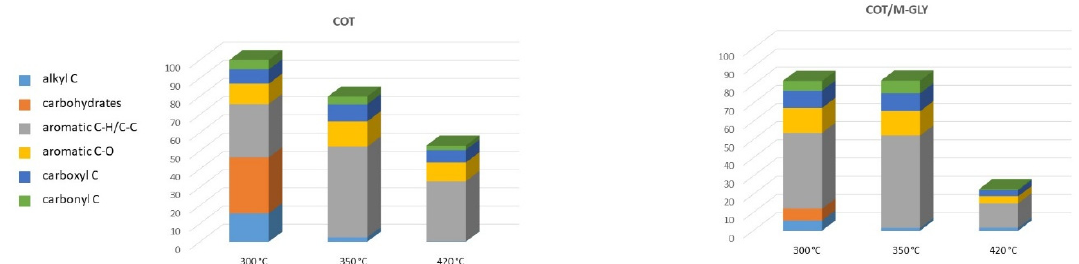
Figure 8. 13 C CP ‐ MAS NMR spectra of residues of COT ( left ) and COT/M ‐ GLY ( right ) after heating in air at 300 °C, 350 °C, and 420 °C (from top to bottom ) recorded at a spinning frequency of 15 kHz. Asterisks indicate spinning sidebands.